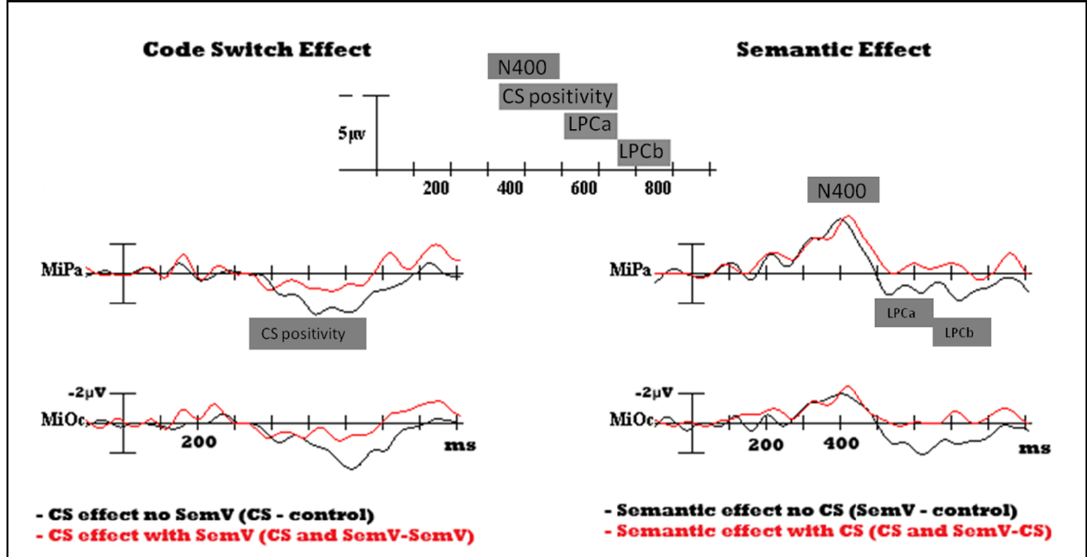
Figure 2. Difference waves of the codeswitch and semantic effects. Difference waves for the codeswitch effect without a semantic violation represent a point-by-point subtraction of the grand averaged response to a codeswitch (CS) minus the control; difference waves for the codeswitch effect with a semantic violation represent a point-by-point subtraction of the grand averaged response to a codeswitched semantic violation (CS and SemV) minus the semantic violation alone (SemV). Difference waves for the semantic effect without a codeswitch are calculated as the response to a semantic violations (SemV) minus the control; the semantic effect with a codeswitch is calculated as the response to a codeswitched semantic violation (CS and SemV) minus the response elicited to codeswitches alone (CS). These waves indicate that code-switches elicit a positivity with a latency onset around 320 ms. This onset overlaps with the first half of the LPC (LPCa) elicited to a semantic violation, but not the